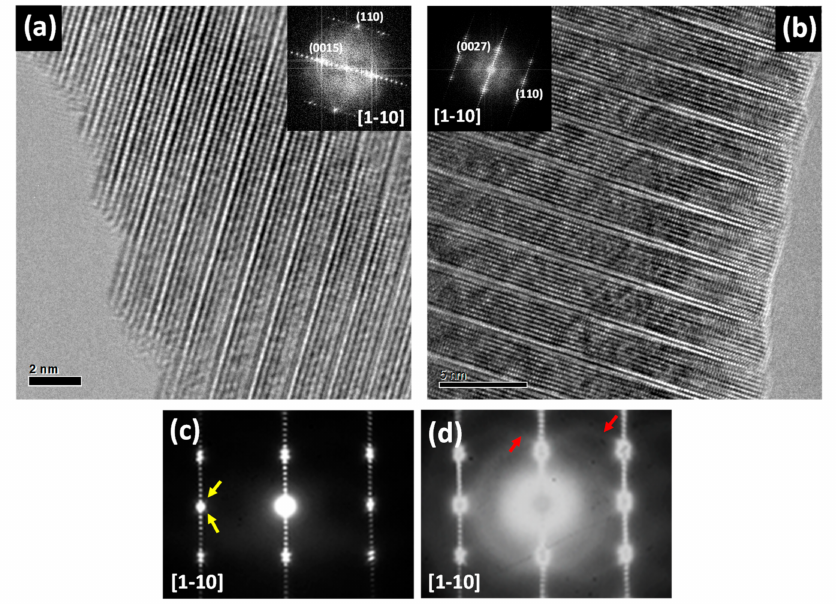
Figure 3. HRTEM images of ( a ) k = 3 and ( b ) k = 7 along the [110] direction. The inset shows the corresponding FFT. ( c ) SAED pattern of k = 7 sample recorded under typical density current of around 10 − 8 A · cm − 2 with 2 s exposure time. ( d ) SAED pattern of k = 7 sample recorded under higher brightness with 16 s exposure